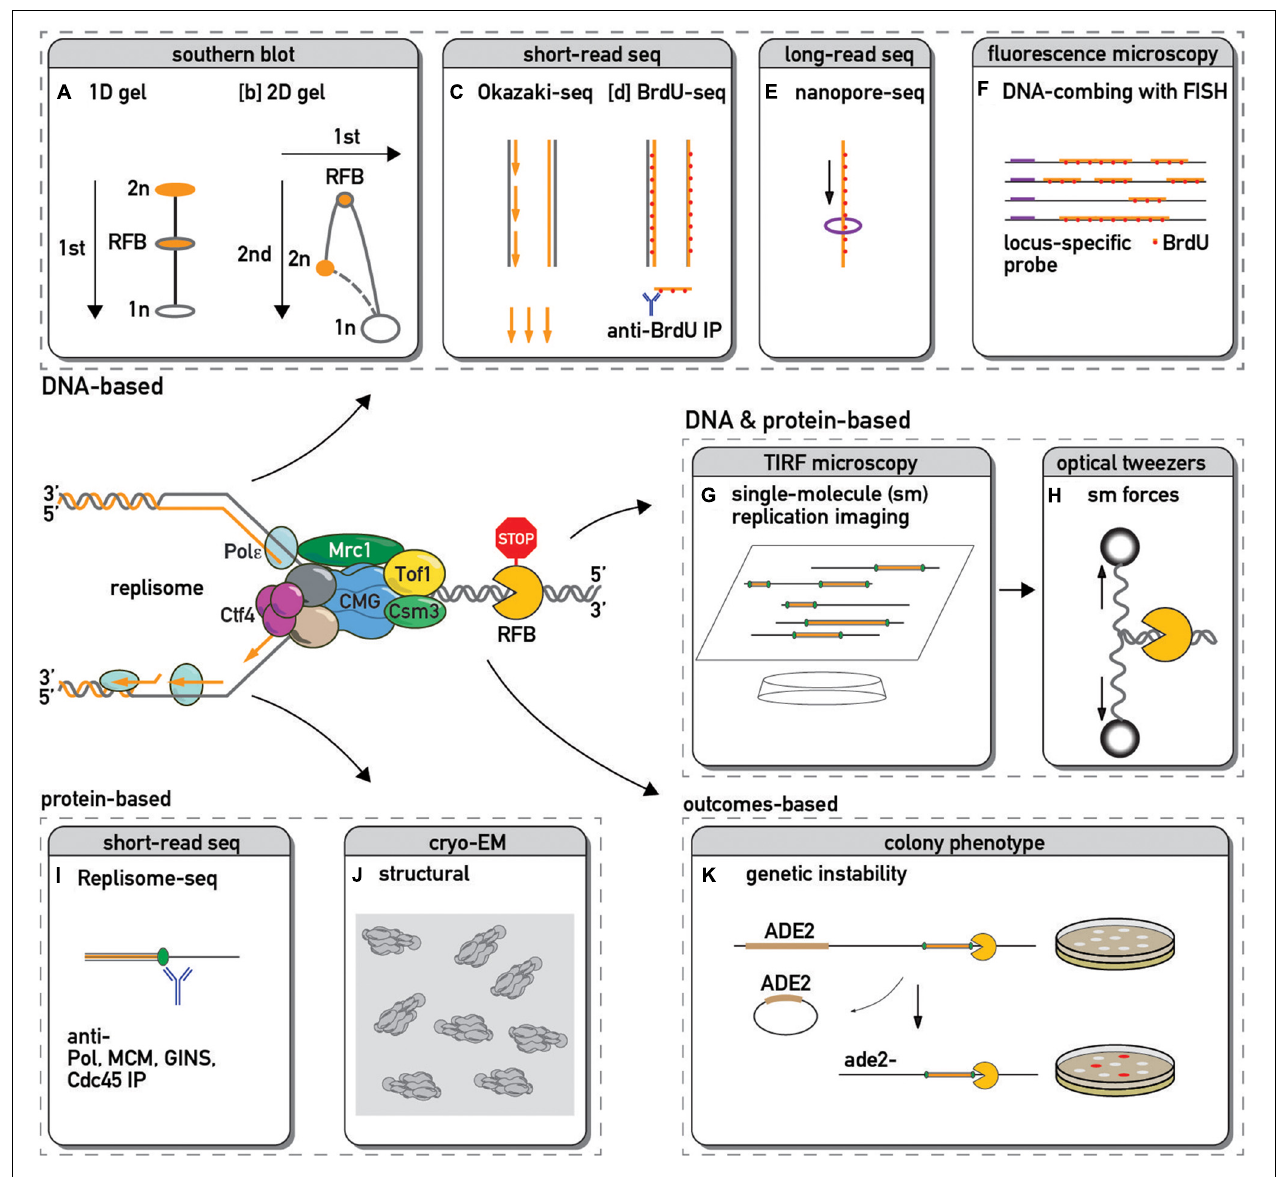
FIGURE 1 | Methods used to study replication fork barriers and replisome pausing. The DNA in and around a paused replication fork is often detected by: 1-dimensional [1D, (A) –(Kobayashi et al., 2004)] or 2-dimensional [2D, (B) –(Brewer and Fangman, 1988)] gel electrophoresis followed by Southern blot and hybridization with a probe specific to a locus of interest; by sequencing and genome mapping of Okazaki fragments [ (C) –(McGuffee et al., 2013)] or immunoprecipitated pieces of sonicated DNA that have incorporated a modified nucleotide analog such as BrdU [ (D) –(Peace et al., 2014)]; by sequencing long stretches of DNA using nanopore technology to infer edges of BrdU incorporation and hence fork positions [ (E) –(Muller et al., 2019)]; by microscopic examination of DNA fibers stretched on slides and immunostained with fluorescently labeled antibody against BrdU or other analogs [ (F) –(Pasero et al., 2002)]. This fluorescent in situ hybridization (FISH) approach with a locus-specific probes allow one to focus only on DNA in the vicinity of a specific barrier. Single-molecule fluorescence microscopy methods allow real-time visualization of replication [ (G) –(Sparks et al., 2019)] or even additional manipulation of the process by changing forces